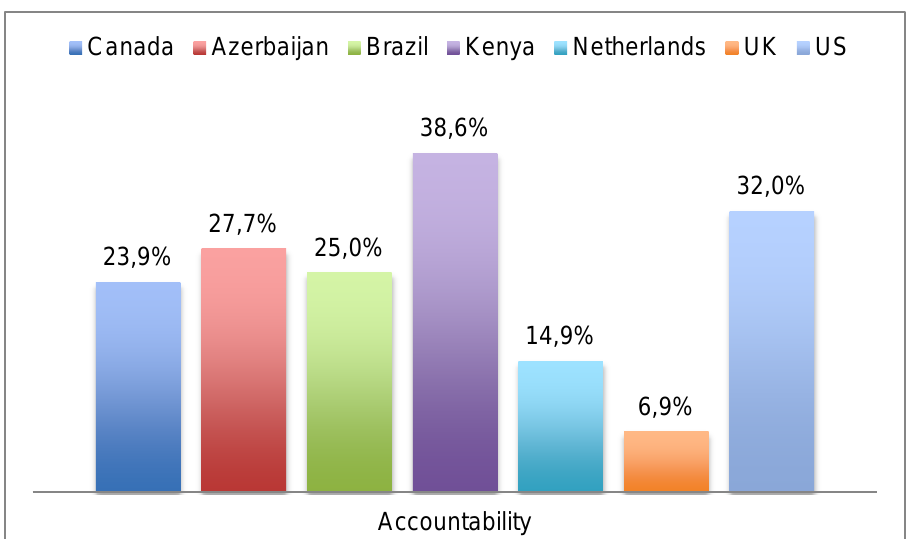
Figure 2: Salience of the code “Accountability” by country Action